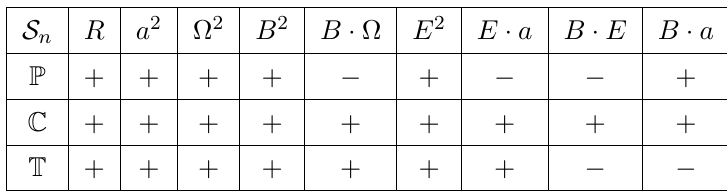
Table 1 . Parity P , charge conjugation C , and time reversal T eigenvalues for the nine second order equilibrium invariants for a U(1) charged relativistic fluid in 3+1D. Since the U(1) charge we have for the super-Yang-Mills plasma is axial, the electric and magnetic fields that appear here are taken to be axial as well. If the U(1) symmetry is vector in nature, then the seven T -even susceptibilities f 1 , . . . f 7 are P -even as